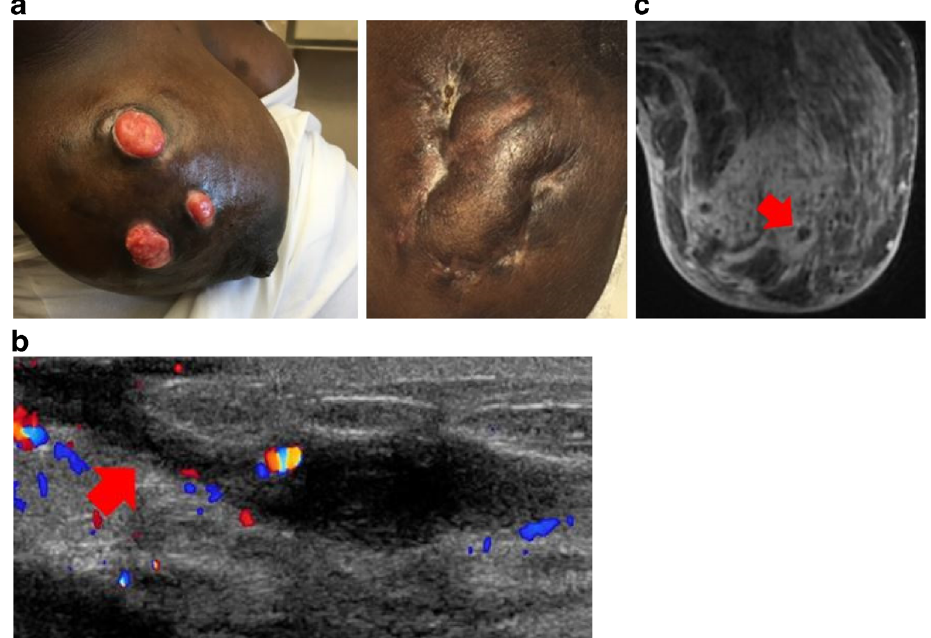
Fig. 7 Idiopathic granulomatous mastitis. A 30-year-old woman in the second trimester of pregnancy had a tender lump in the right breast. She had first noticed a lump in the upper outer right breast approximately 2 months previously, and it had increased in size. On physical examina- tion, there was a 10 × 10-cm firm mass in the upper outer quadrant. Biopsies showed acute and chronic granulomatous inflammation with